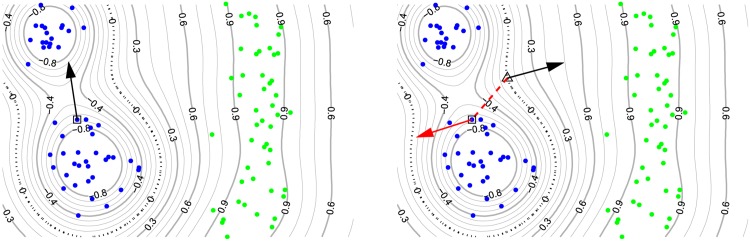
An exemplary real-valued prediction function for classification with the dashed black line being the decision boundary which separates the blue from the green dots.The blue dots are labeled negatively, the green dots are labeled positively. Left: Local gradient of the classification function at the prediction point. Right: Taylor approximation relative to a root point on the decision boundary. This figure depicts the intuition that a gradient at a prediction point x—here indicated by a square—does not necessarily point to a close point on the decision boundary. Instead it may point to a local optimum or to a far away point on the decision boundary. In this example the explanation vector from the local gradient at the prediction point x has a too large contribution in an irrelevant direction. The closest neighbors of the other class can be found at a very different angle. Thus, the local gradient at the prediction point x may not be a good explanation for the contributions of single dimensions to the function value f(x). Local gradients at the prediction point in the left image and the Taylor root point in the right image are indicated by black arrows. The nearest root point x
0 is shown as a triangle on the decision boundary. The red arrow in the right image visualizes the approximation of f(x) by Taylor expansion around the nearest root point x
0. The approximation is given as a vector representing the dimension-wise product between Df(x
0) (the black arrow in the right panel) and x − x
0 (the dashed red line in the right panel) which is equivalent to the diagonal of the outer product between Df(x
0) and x − x
0.